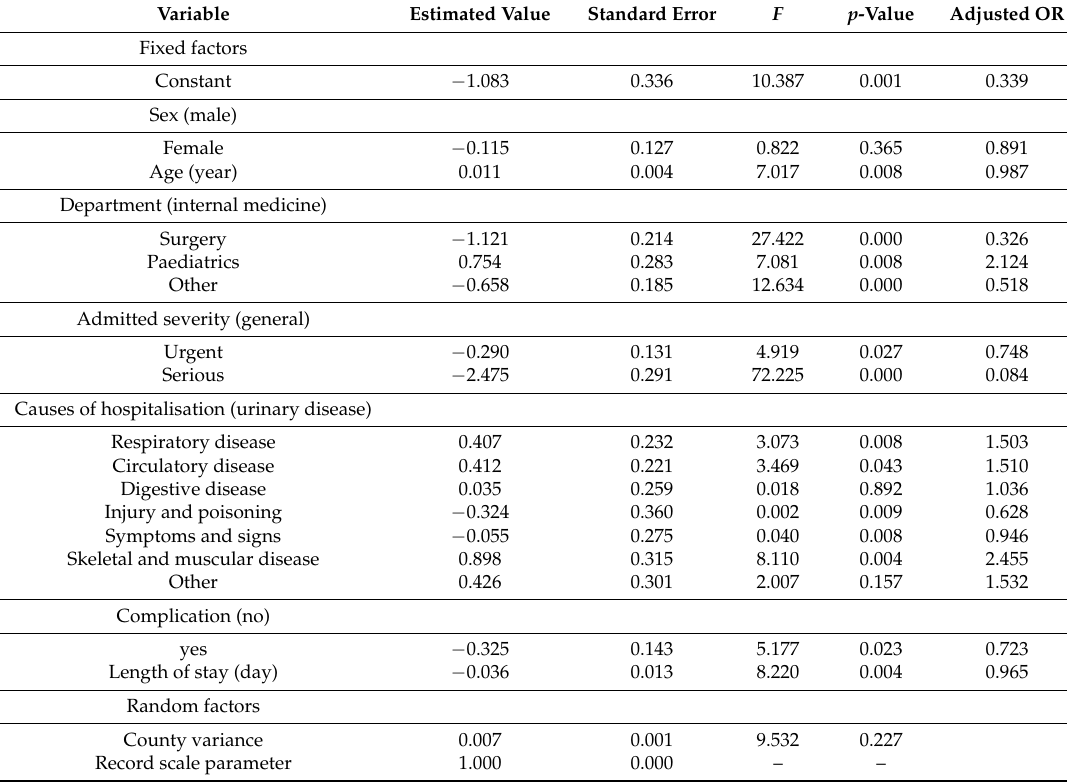
Table 3. Two-level logistic regression analysis of inappropriate admissions ( n =